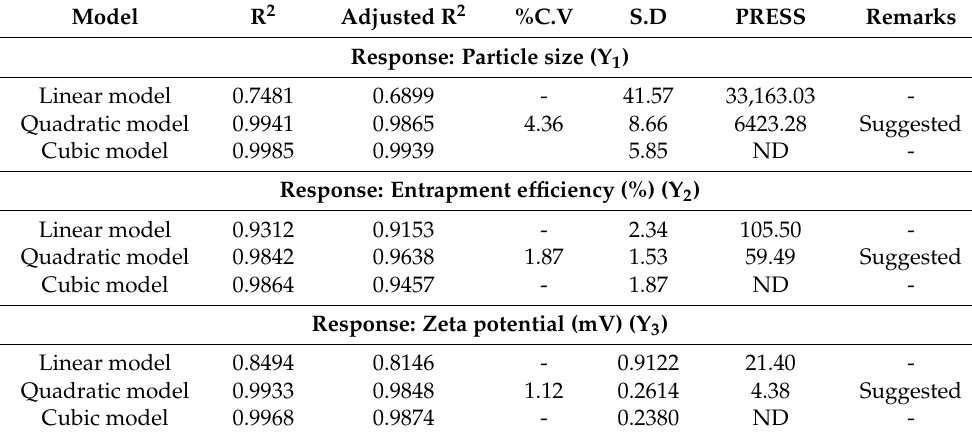
Table 3. Summary of results of regression analysis for